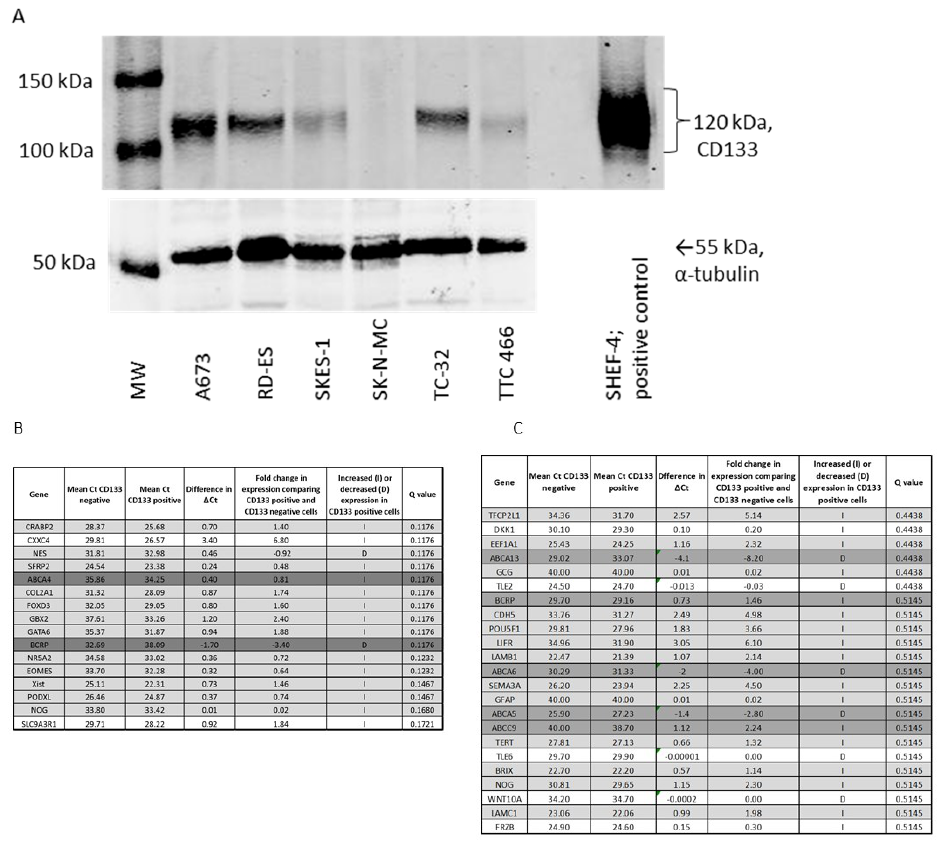
Figure 2. Characterisation of CD133 cells in ES cell lines. ( A ) Protein expression of CD133 in ES cell lines ( n = 6) was evaluated by Western blot. Equal protein loading was confirmed by probing the blots for α -tubulin. The top differentially expressed genes comparing ( B ) TC-32 and ( C ) A673 CD133- positive and -negative cells using LIMMA were not significant. The difference in ∆ Ct between the two groups and corresponding Q values are shown. Genes were considered significantly differentially expressed if the Q value was <0.1 and the difference in ∆ Ct > 2. Genes with Ct values of >35 in both cell populations were excluded. Dark grey = ABC transporter proteins, grey = pluripotency associated genes, white = Wnt signalling pathway genes. Results of two independent experiments. SHEF-4 embryonic stem cells were included as a positive control for CD133 expression